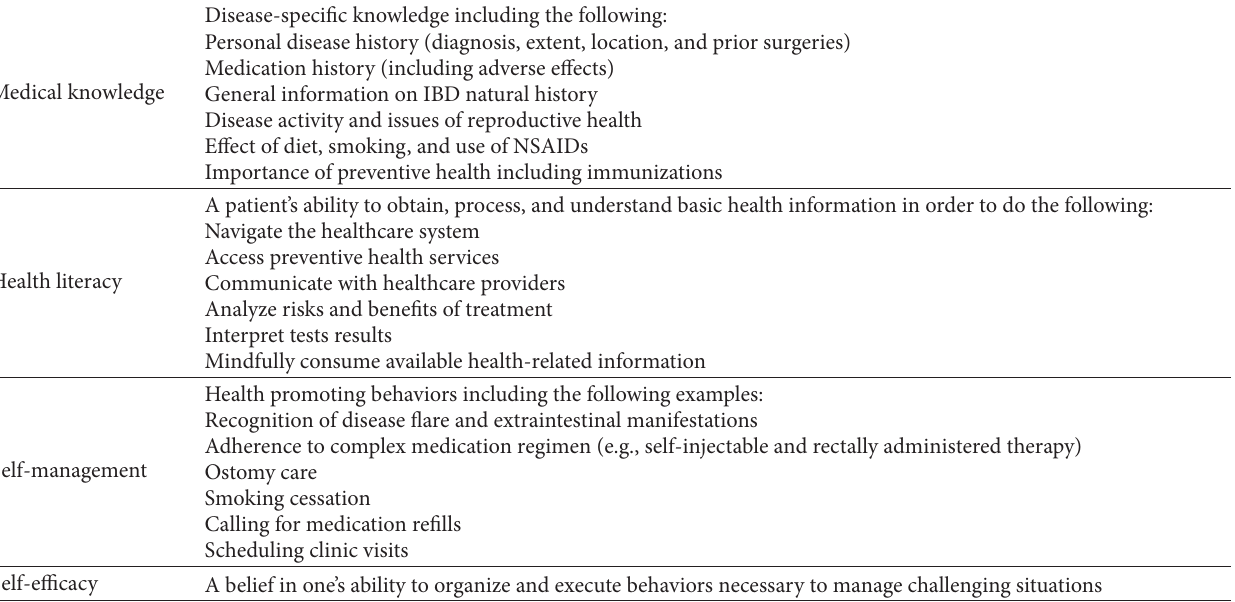
Table 3: Patient core-competencies for success after transition to adult